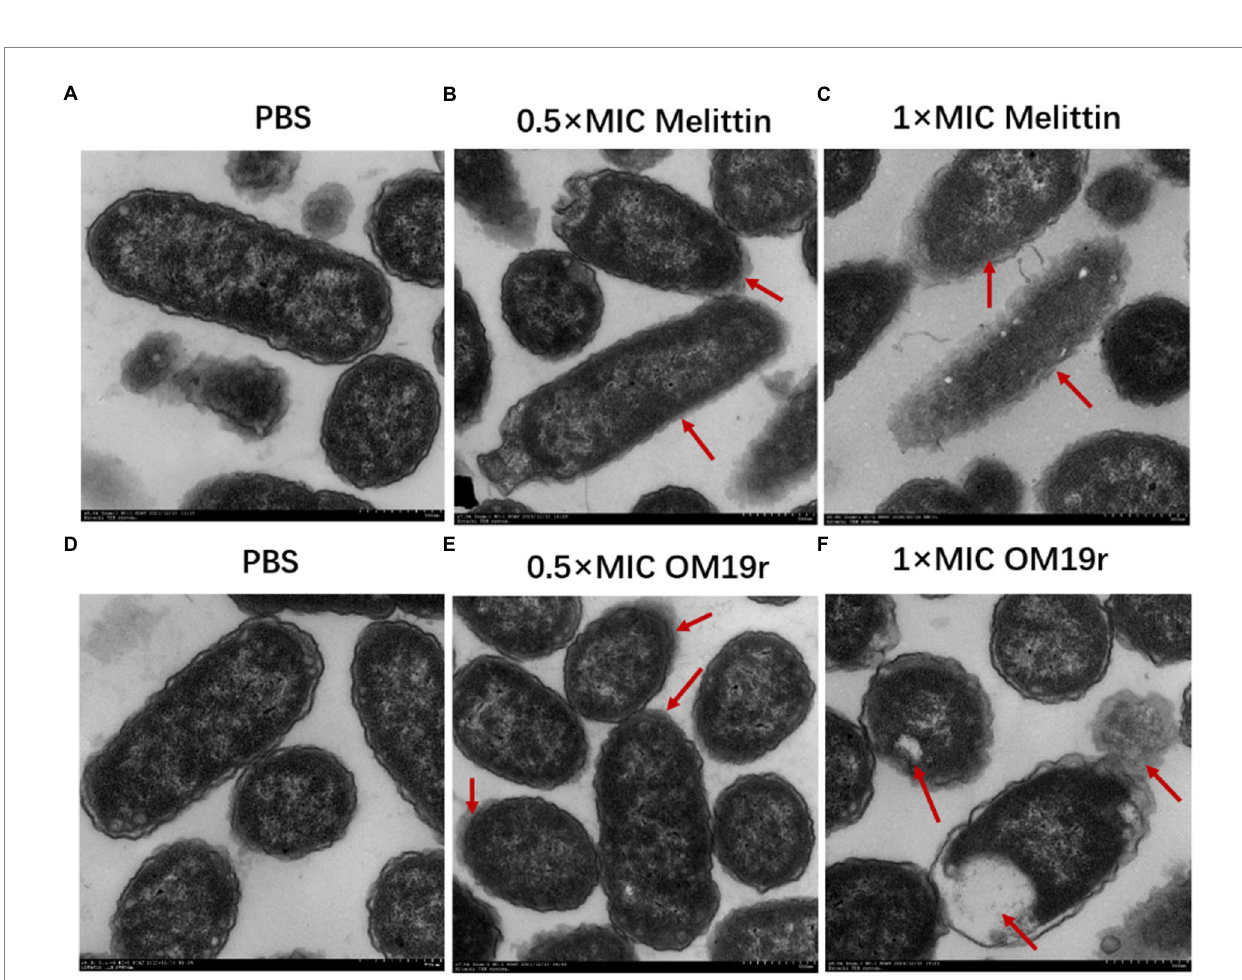
FIGURE 7 Transmission electron microscopy results of E. coli B2 treated with OM19r. ( A) Transmission electron microscopic images of E. coli B2. (B) Transmission electron microscopic images of E coli B2 treated with Melittin (0.5 × MIC) for 1 h. (C) Transmission electron microscopic images of E coli B2 treated with Melittin (1 × MIC) for 1 h. (D) Transmission electron microscopic images of E. coli B2. E ， Transmission electron microscopic images of E coli B2 treated with OM19r (0.5 × MIC) for 1 h. D, Transmission electron microscopic images of E coli B2 treated with OM19r(1 × MIC) for 1 h. Red arrows in B, C, and E points to the cell membrane;The red arrow in F points to intracellular